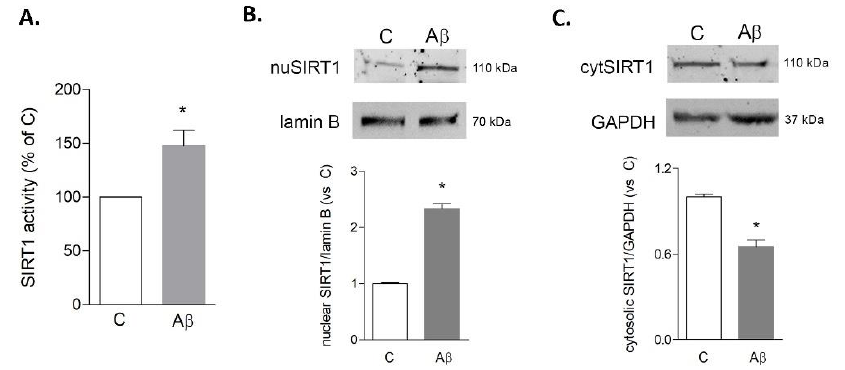
Figure 4. Activity and subcellular localization of SIRT1 in HMC3 cells upon Aβ42 exposure. Cells were treated for 6 h with Aβ42 (0.2 μM). SIRT1 enzymatic activity was evaluated in lysates im- munoprecipitated for SIRT1 ( A ). Nuclear ( B ) and cytosolic ( C ) expression of SIRT1 were investigated by Western blot analysis on purified fractions. Representative blots are shown. Results are the mean ± SEM of three independent experiments. * p < 0.05 vs. C by Student’s t -test for significance. To further strengthen this result and monitor the sub-cellular localization of SIRT1 in time, cells were immunostained and counted for nuclear SIRT1 positivity.